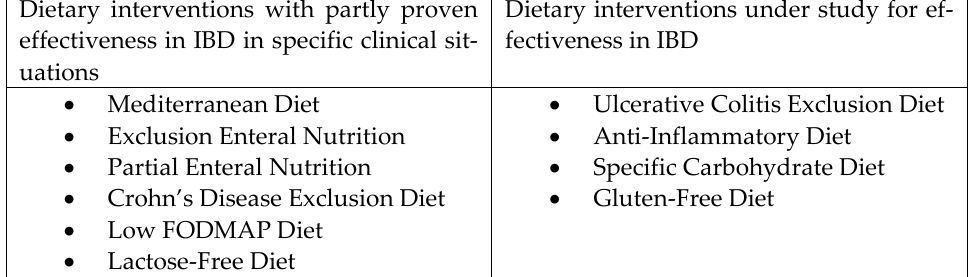
Figure 1. Dietary interventions included in the article that are applicable or potentially